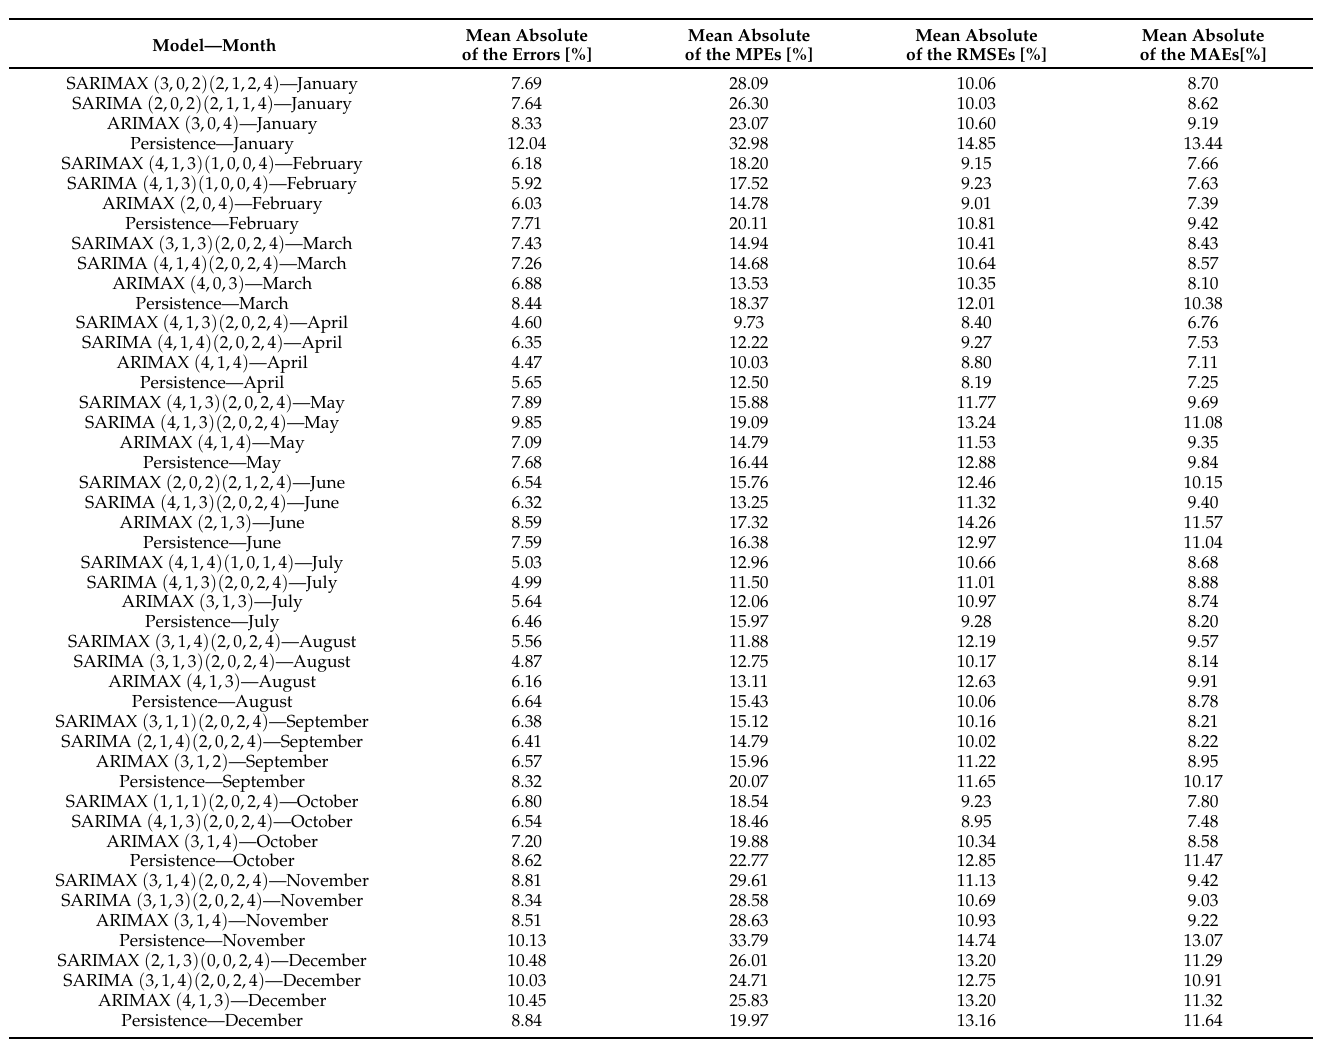
Table A1. Comparison between ARIMA-based and persistence models for all months of the year. The results reported here are based on 4 different performance metrics. Model—Month Mean Absolute Mean Absolute Mean Absolute Mean Absolute of the Errors [%] of the MPEs [%] of the RMSEs [%] of the MAEs[%] SARIMAX ( 3,0,2 )( 2,1,2,4 )